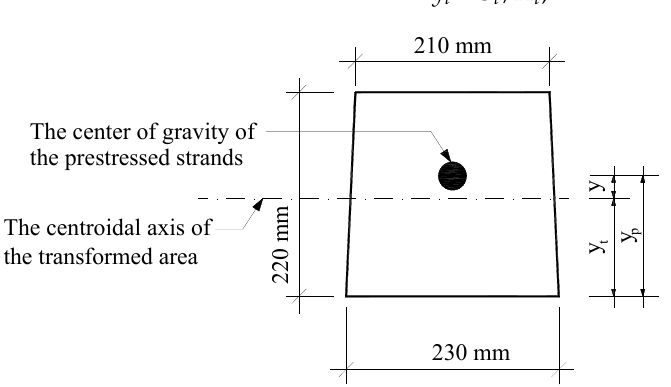
Figure 3. Eccentricity of the centroid of the prestressed force of the bearer.